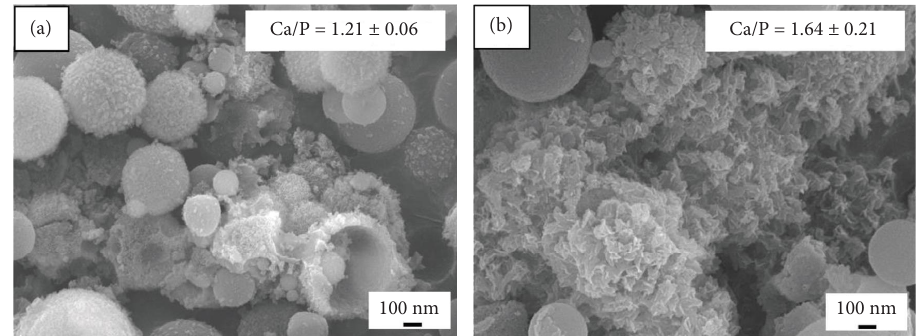
Figure 5: Surface morphology of (a) pure BG powder and (b) PEG-derived-BG powder after immersion in SBF for 12 h.